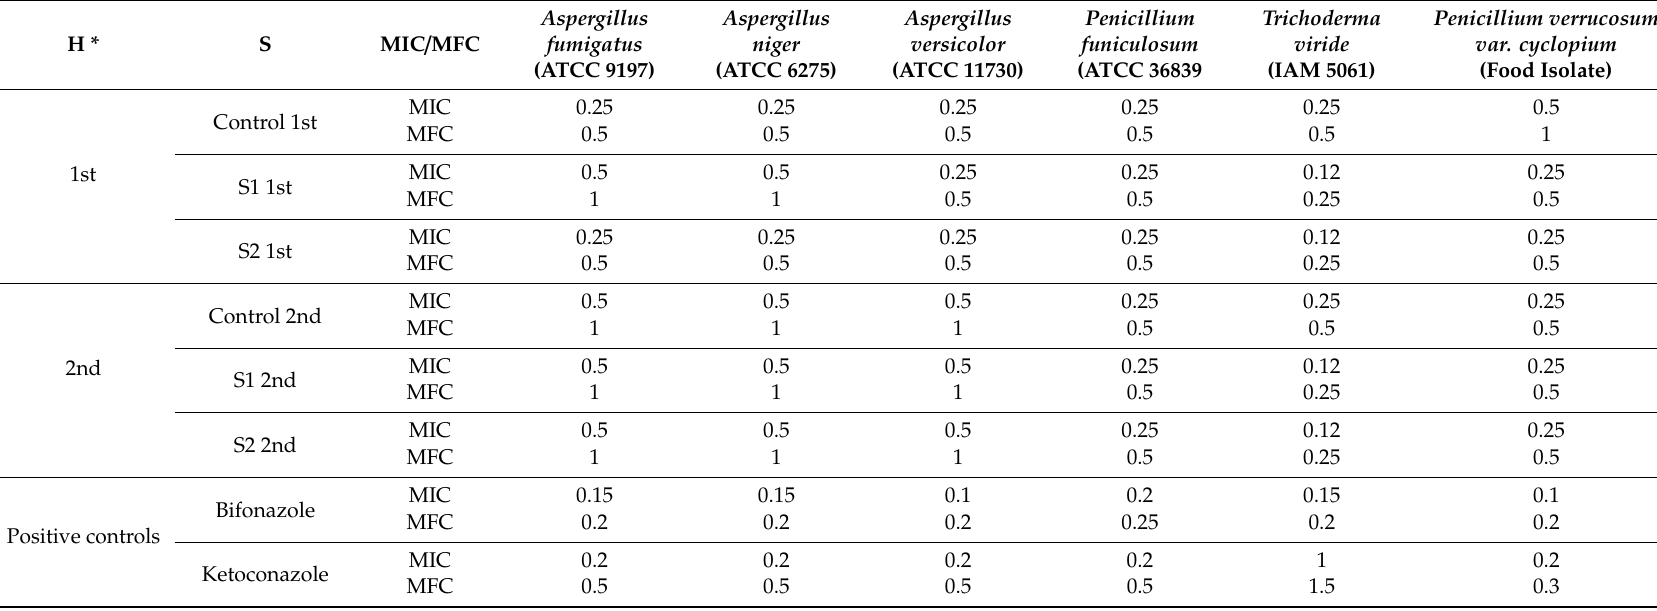
Table 12. Antifungal activity of Centaurea raphanina subsp. mixta leaves’ hydroethanolic extracts in relation to salinity level (control, S1 and S2) and harvesting time (MIC and MFC mg /